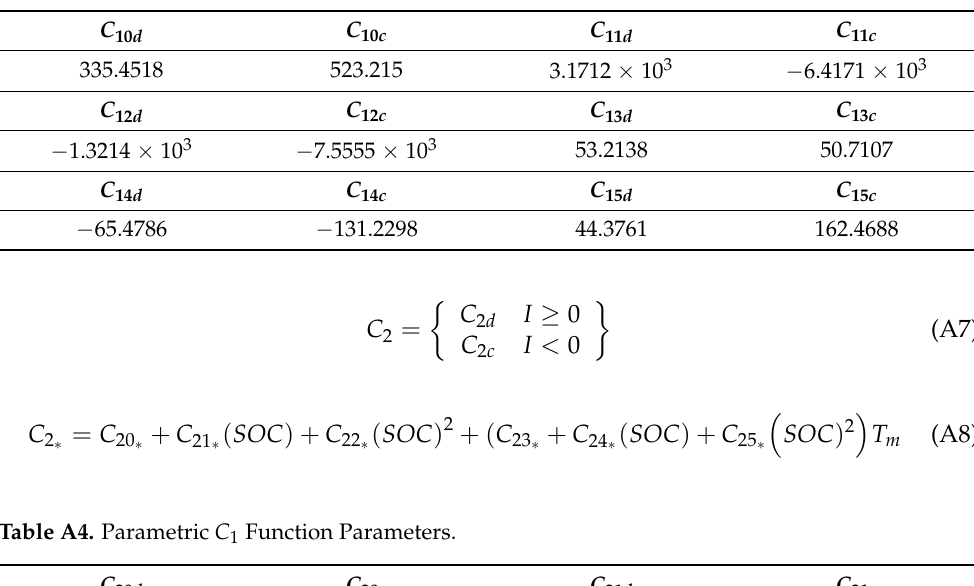
Table A3. Parametric C 1 Function Parameters.